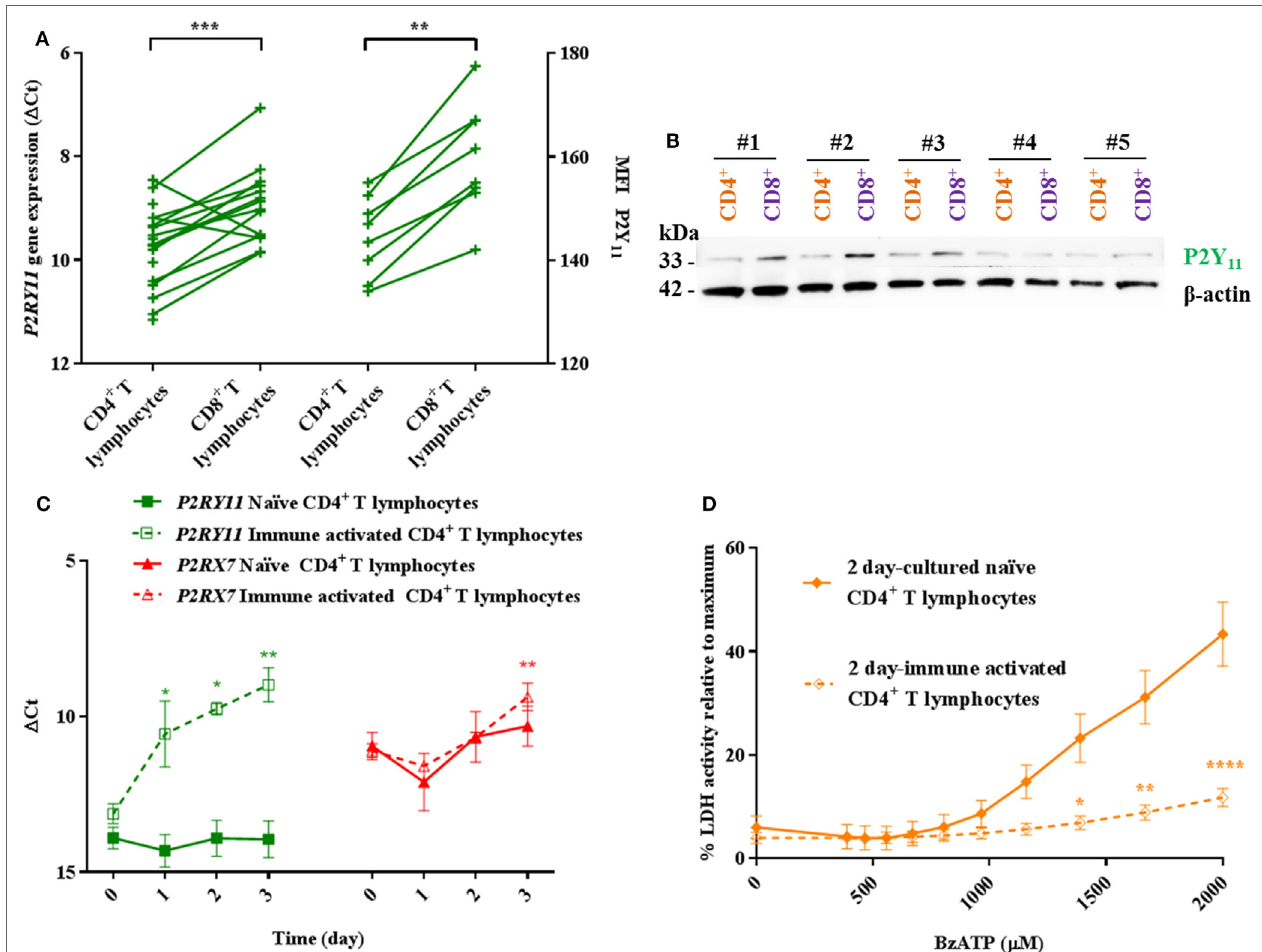
FigUre 3 | Higher P2Y 11 levels in CD8 + T lymphocytes and immune-activated CD4 + T lymphocytes correlate with lower responses to BzATP compared to naïve CD4 + T lymphocytes. (a) Left axis: P2RY11 gene expression in human CD4 + and CD8 + T lymphocytes shown as Δ Ct values normalized to the genes for GAPDH and ACTB ( β -actin) from 14 to 18 independent donors. Right axis: mean fluorescence intensity (MFI) as measured by flow cytometry on eight independent donors. (b) Western blot membrane with protein lysate of CD4 + (orange) and CD8 + (purple) T lymphocytes from five different donors (#1–5) following stripping and re-blotting for P2Y 11 signal (33 kDa). Loading control was β -actin (42 kDa) after stripping and re-blotting. (c) Δ Ct values for human P2RY11 (green) and P2RX7 (red) gene expression over time in naïve and immune-activated CD4 + T lymphocytes. Values were normalized to the genes for B2M and EEF1A1 from three independent donors. (D) Lactate dehydrogenase (LDH) activity in the supernatant following 2 h incubation with various concentrations of BzATP of 2-day cultured naïve (filled rhomb) or immune-activated (open rhomb) CD4 + T lymphocytes. Data are shown as mean ± SEM of maximum induced cell death at 1% Triton X-100, n = 4–6 from three independent